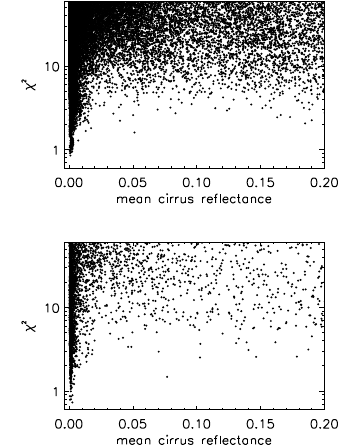
Figure 8. The χ 2 of the retrieval vs. the mean cirrus reflectance in the full-resolution (top) and medium-resolution (bottom) scenes. The coarse mode real refractive index filter has been applied to the data in this